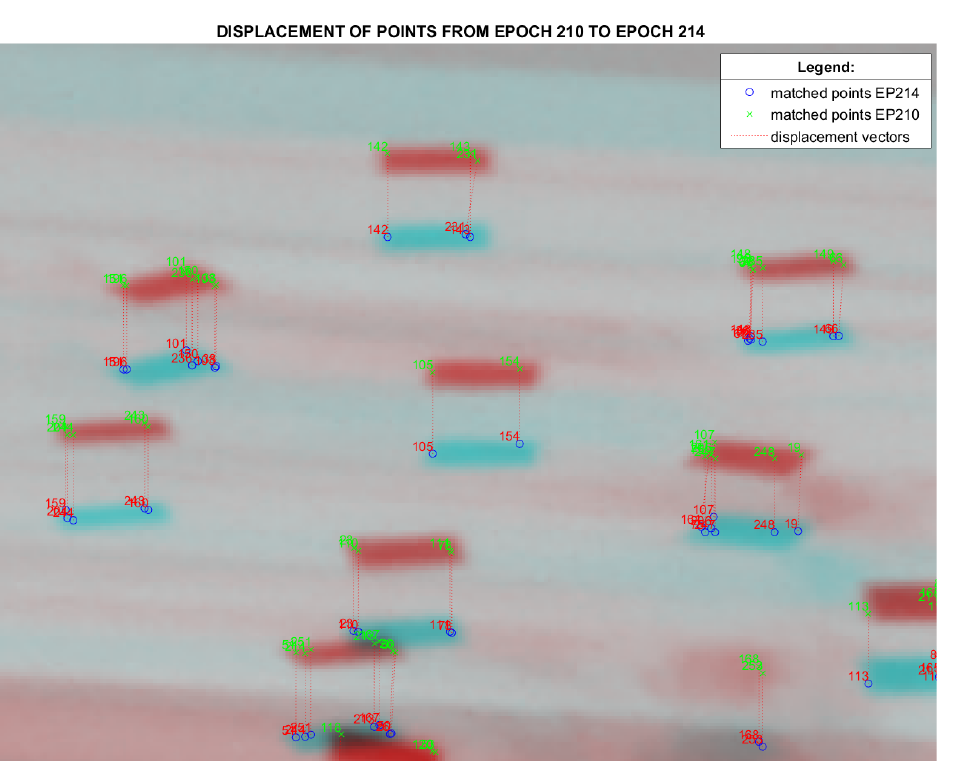
Figure 11. Example of plotted identical points and image displacement vectors between two epochs (Source: Own